Question: What caption would you write for this figure?
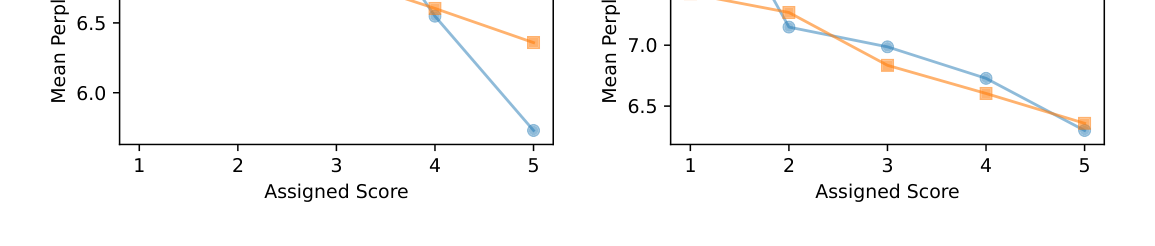
Answer: Average Perplexity associated with Automatic Evaluation Score, for each Attribute. While GPT-4 shows a preference for low perplexity samples, GPT-3.5-Turbo seems to show a dis-preference for high perplexity examples.